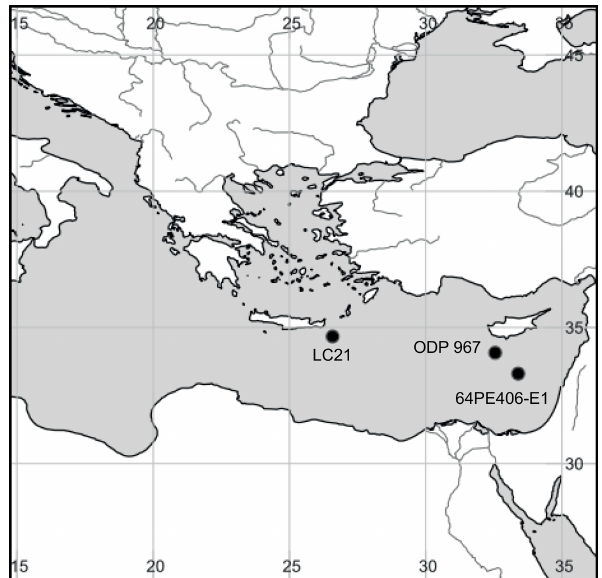
Figure 2. Map of the eastern Mediterranean showing the loca- tions of sapropel cores used in this study. LC21: low-resolution S1, S2, S3, and S5 sapropels from the Aegean Sea; 64PE406: high- resolution S5 sapropel from the Levantine Basin; ODP 967: high- resolution Pliocene sapropel from the Levantine Basin. Map created with SimpleMappr: David P. Shorthouse, 2010. SimpleMappr is an online tool to produce publication-quality point